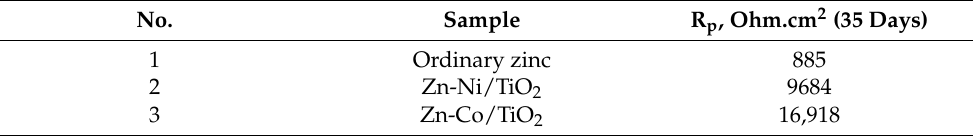
Table 3. Polarization resistance measurements after 35 days immersion in 5% NaCl.